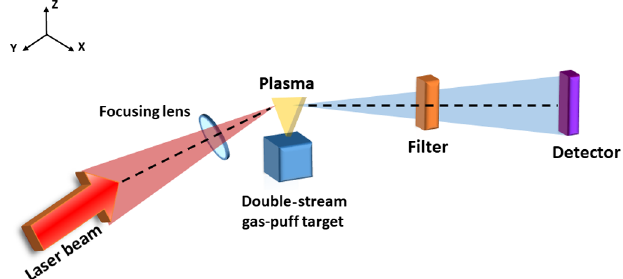
FIG. 1. Scheme of the experimental setup for EUV and SXR plasma emission